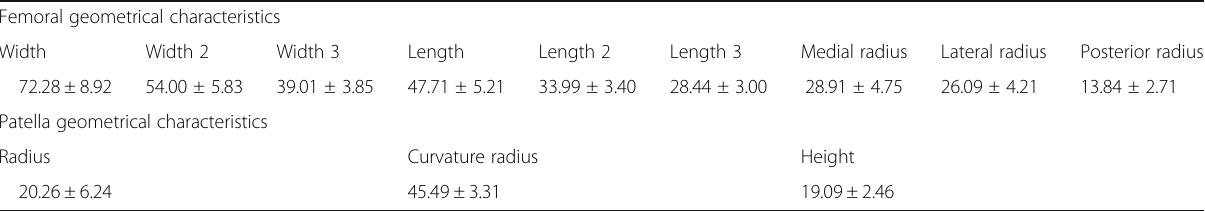
Table 1 Mean values (mm) and standard deviation (±) (mm) of the geometrical parameters defining the parametric PFJ measured on the 24 knees (Sanchis-Alfonso et al.